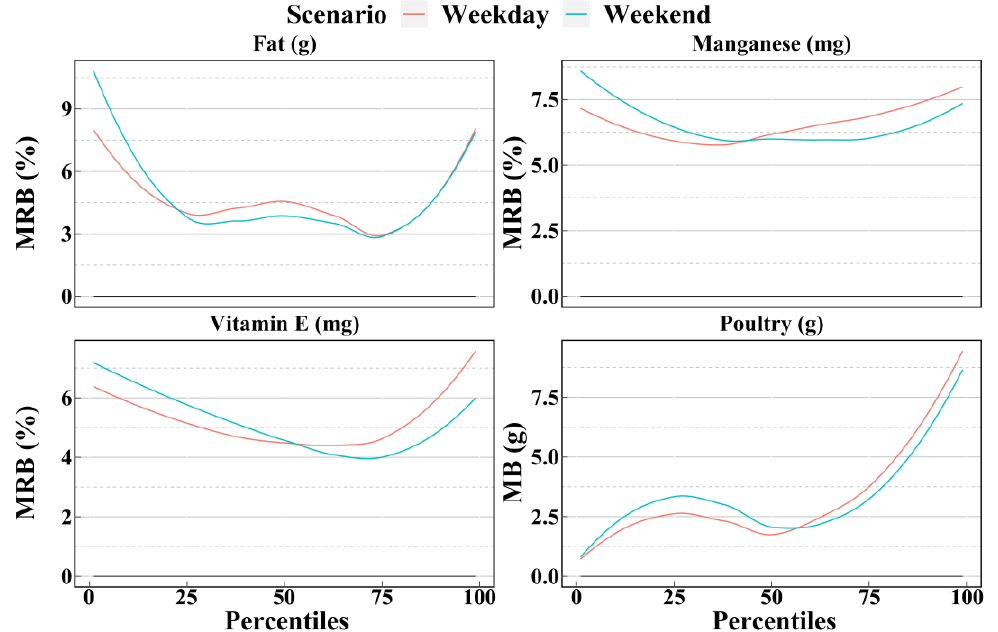
Figure 9. Smooth curves of the percentile (from 1st to 99th) intakes of dietary components in group 3 estimated by weekday and weekend of scenario NC2 based on the NCI method. Smooth curves of the bias and relative bias for each dietary component in group 3 calculated by the 4 scenarios are available in Supplementary Figure S6. Weekday = Two non-consecutive weekdays; Weekend = Of the two non-consecutive days, one was a weekend, and the other was a weekday; MRB = Mean relative bias; MB = Mean bias.